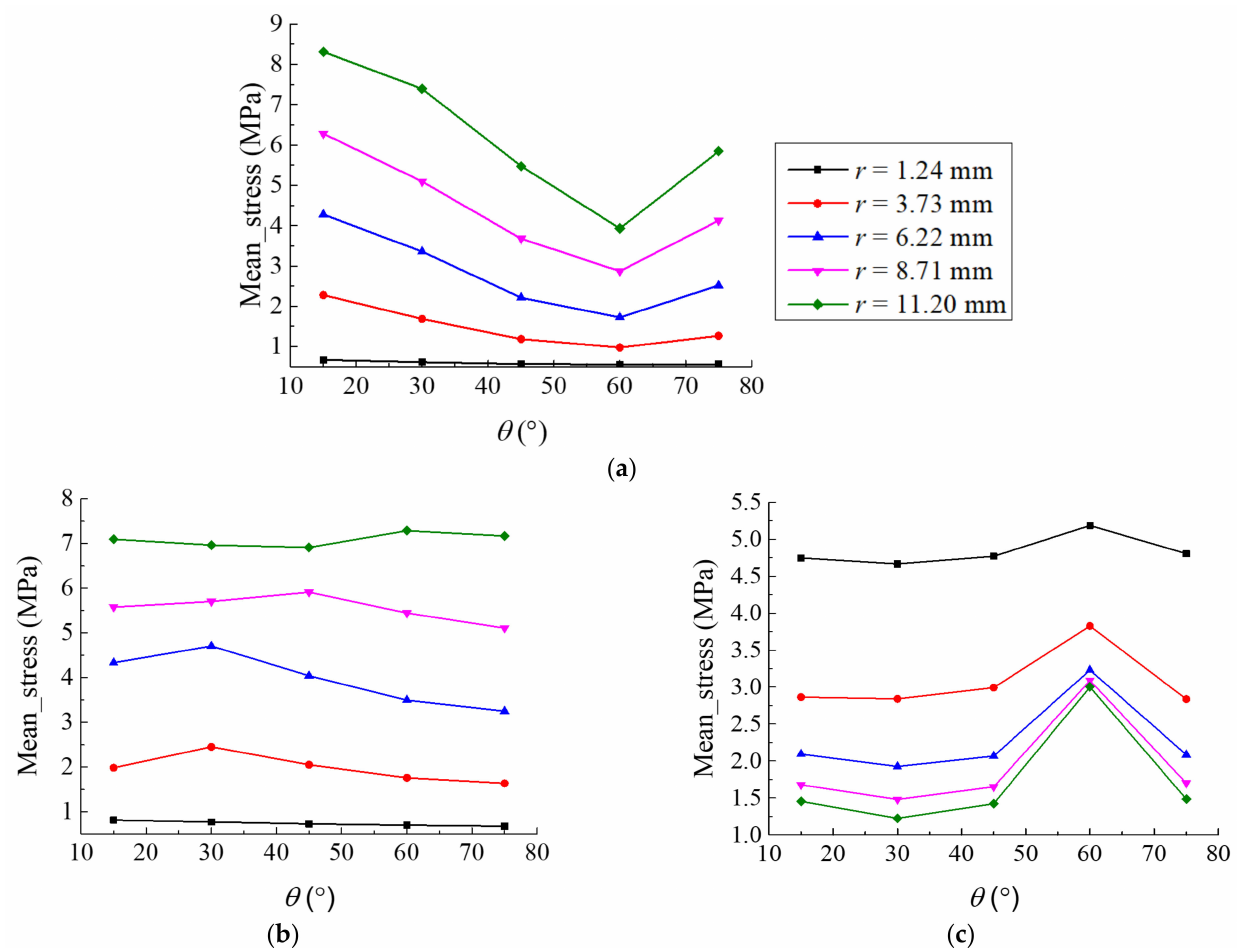
Figure 11. Mean stress under the compression of the origami honeycomb: ( a ) in the in-plane direction along the y-coordinate, ( b ) in the in-plane direction along the x-coordinate, and ( c ) in the out-of-plane